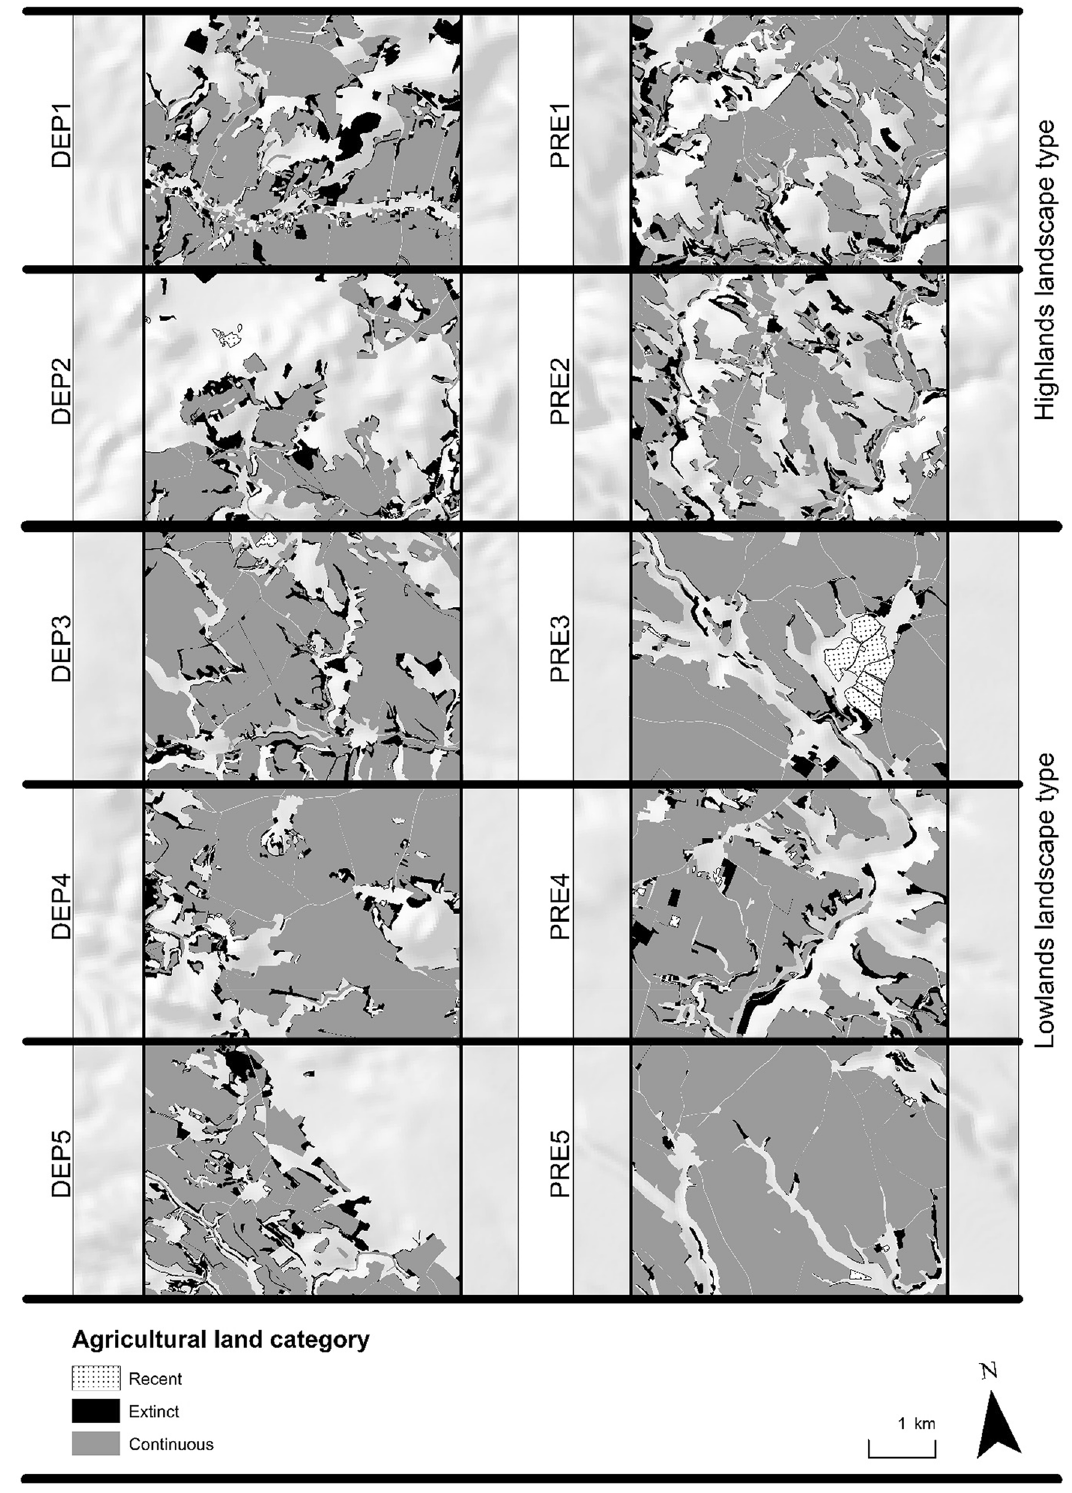
Figure 4. Spatial distribution of agricultural land persistence categories within the studied sites (maps created in the ArcGIS 10.6 software 34